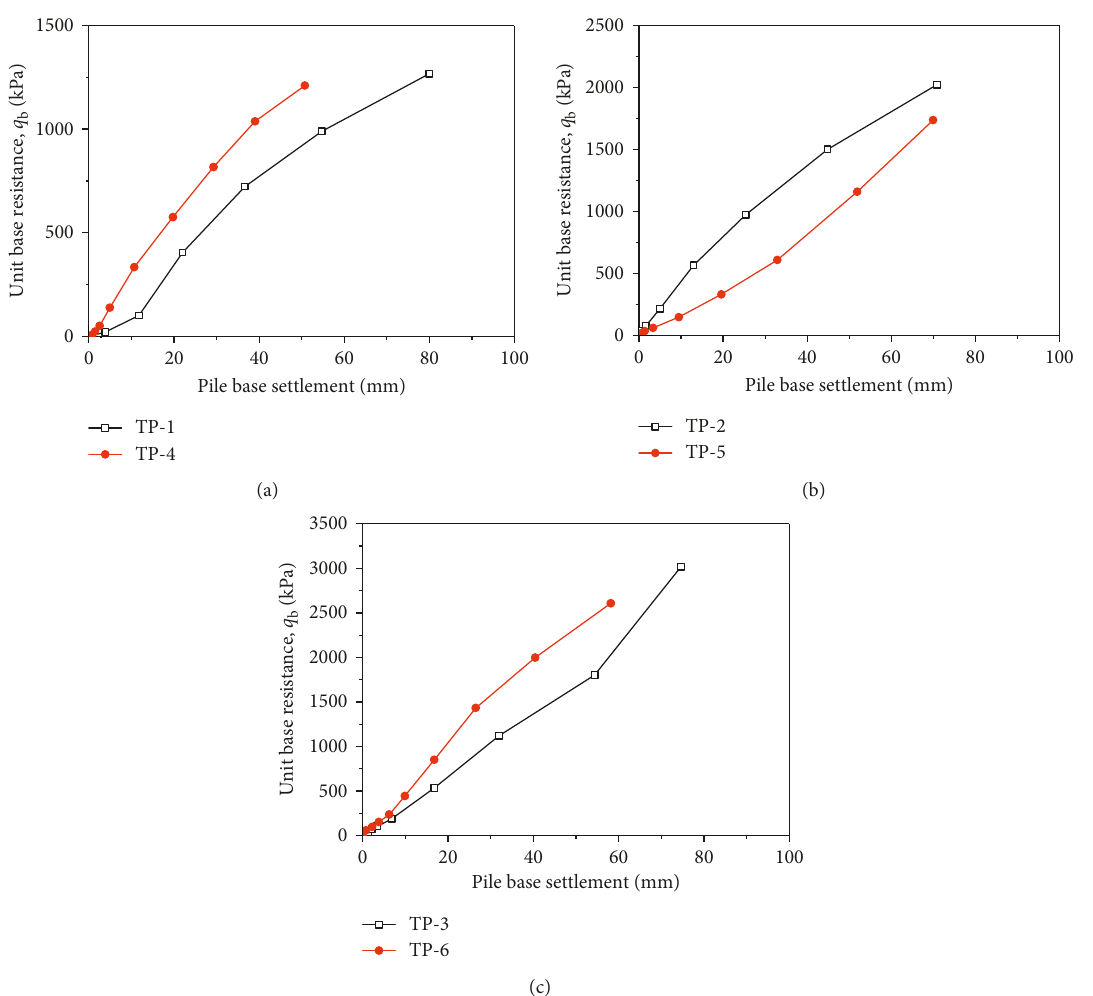
Figure 9: Measured unit base resistance versus pile head settlement for all piles. (a) TP-1 and TP-4 with L L 18.0m; (c) TP-3 and TP-6 with L (cid:31)